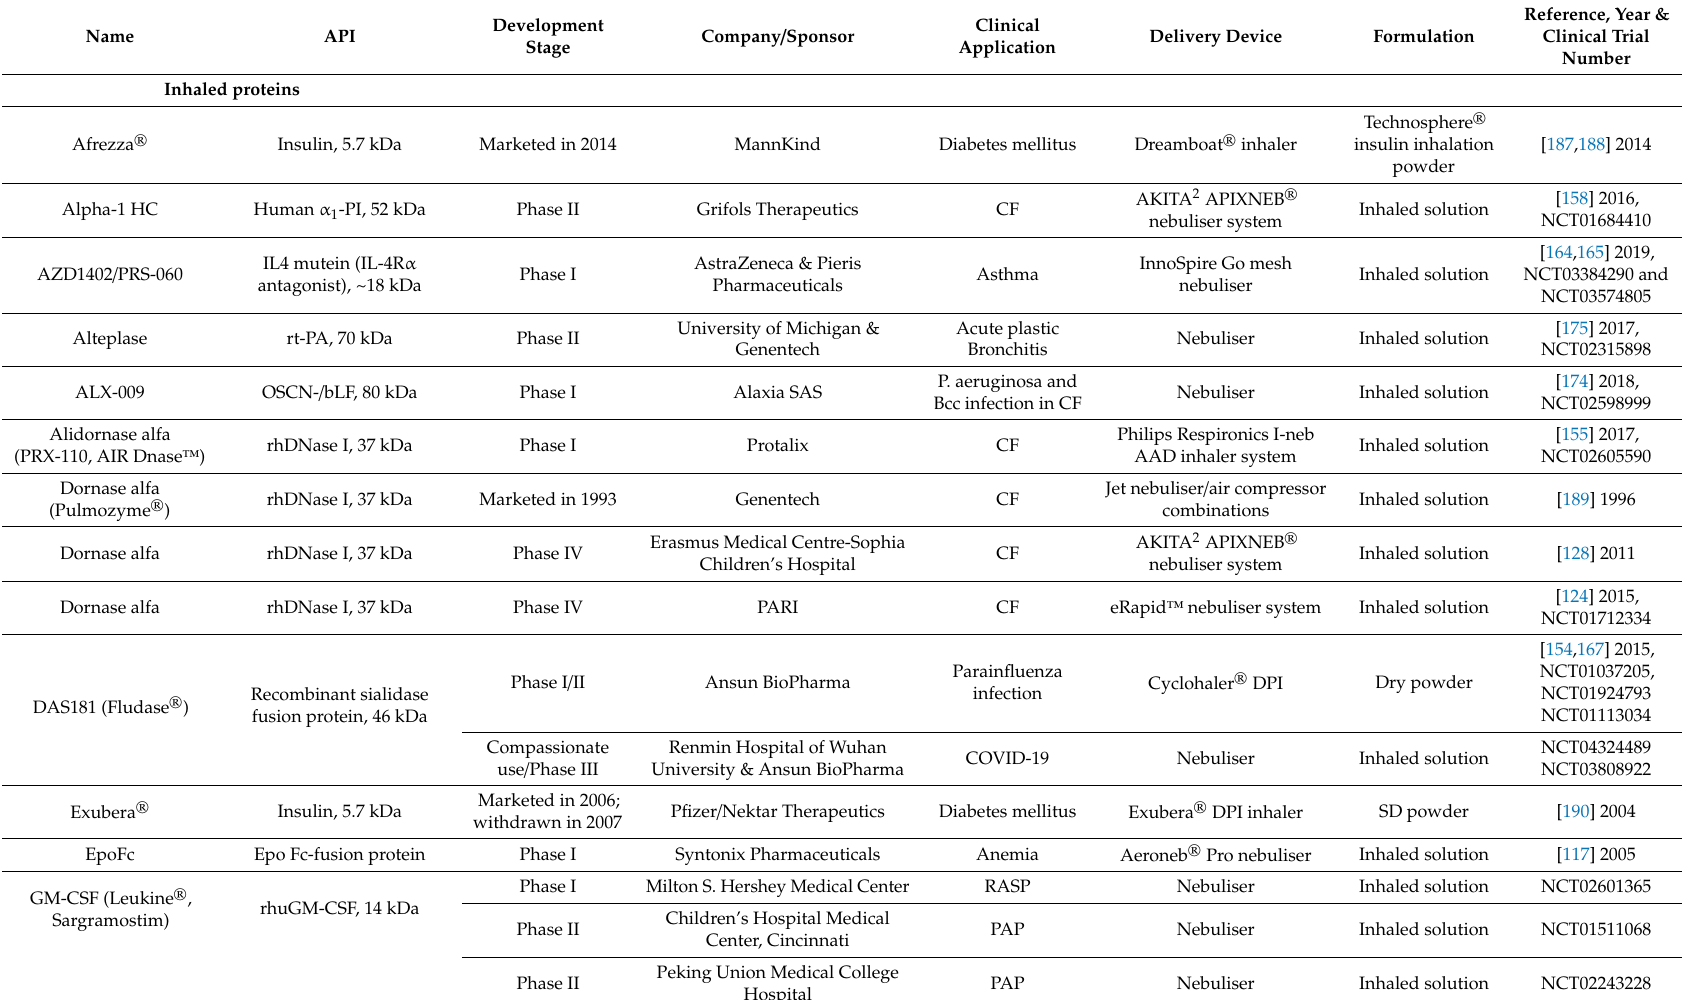
Table 4. Selected clinical studies and marketed products of inhaled biologic